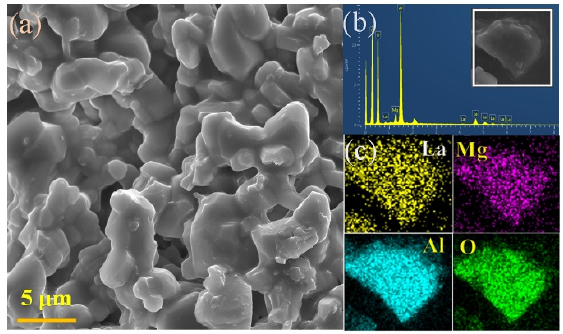
Figure 4. ( a ) Scanning electron microscope (SEM) image of LMA/0.01Mn 4+ ; ( b ) EDS spectra of LMA/0.01Mn 4+ ; ( c ) SEM and element distribution mapping of the corresponding sample.